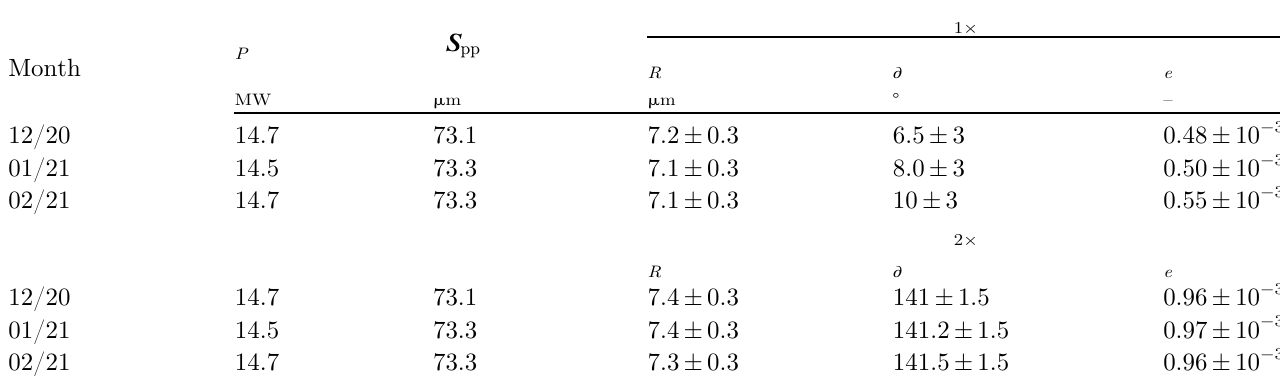
Table 1. Monthly average values of Produced Power P , overall peak-to-peak relative shaft displacement S requirement), 1 (cid:4) and 2 (cid:4) proposed orbital features: major semiaxis R , inclination angle # , eccentricity e